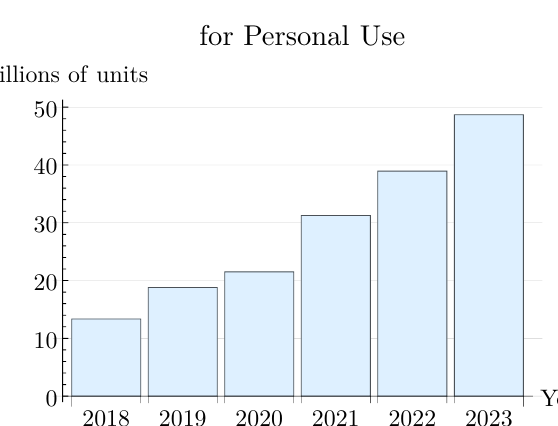
Figure 6. Service robots potential development for personal/domestic use.